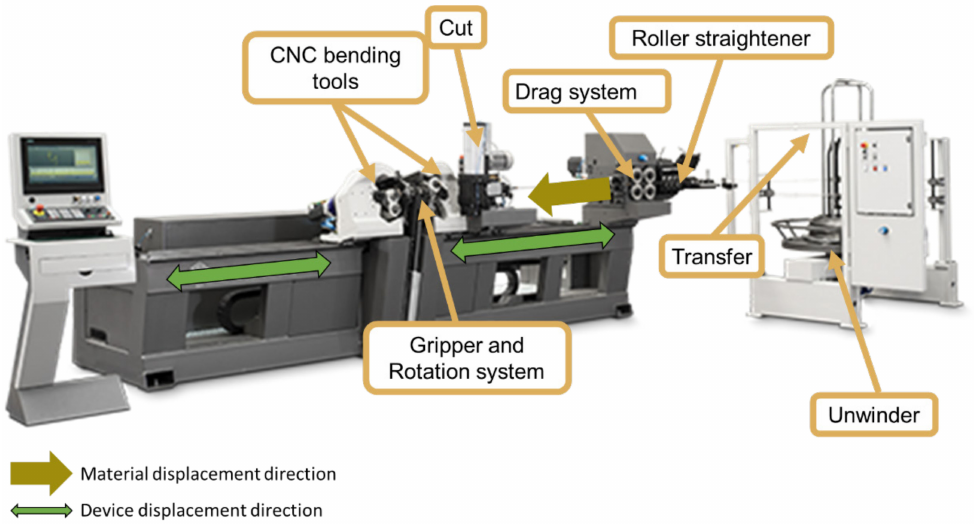
Figure 7. Wire-bending equipment DH4012 VGP (BLM